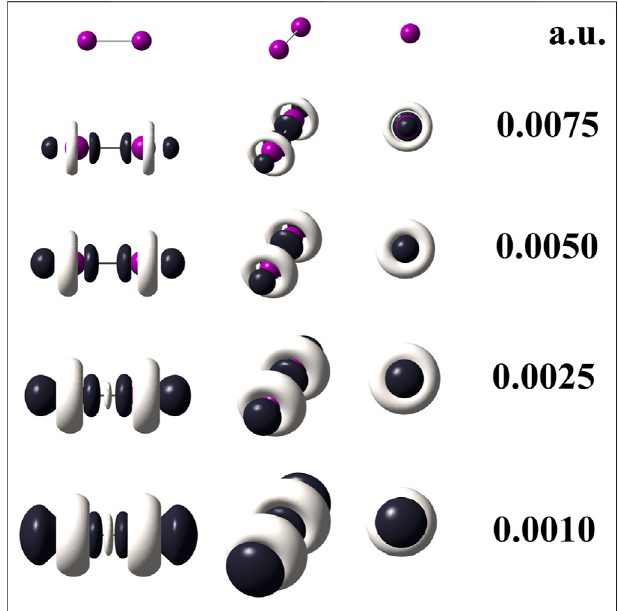
FIGURE 3 | Dual descriptor (DD) of diiodine computed at the M06 – L/ def2-QZVPPD at different isovalues given in atomic units. To use Eq. 3 , the following total electron densities were employed: ρ ( r ) 2 51 , ρ ( r ) 1 50 , and ρ ( r ) 3 48 . Purple spheres stand for iodine atoms, black – colored lobes represent positive values of DD ( f (2) ( r ) > 0); white – colored lobes correspond to negative values of DD ( f (2) ( r ) < 0).